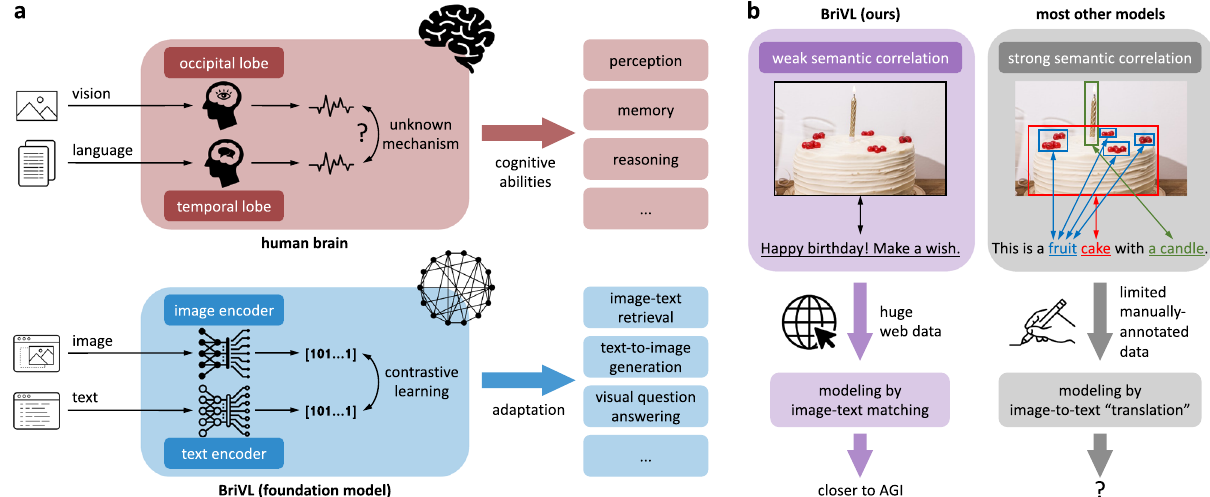
Fig. 1 Overarching concept of our BriVL model with weak training data assumption. a Comparison between the human brain and our multimodal foundation model BriVL (Bridging-Vision-and-Language) for coping with both vision and language information. b Comparison between modeling weak semantic correlation data and modeling strong semantic correlation